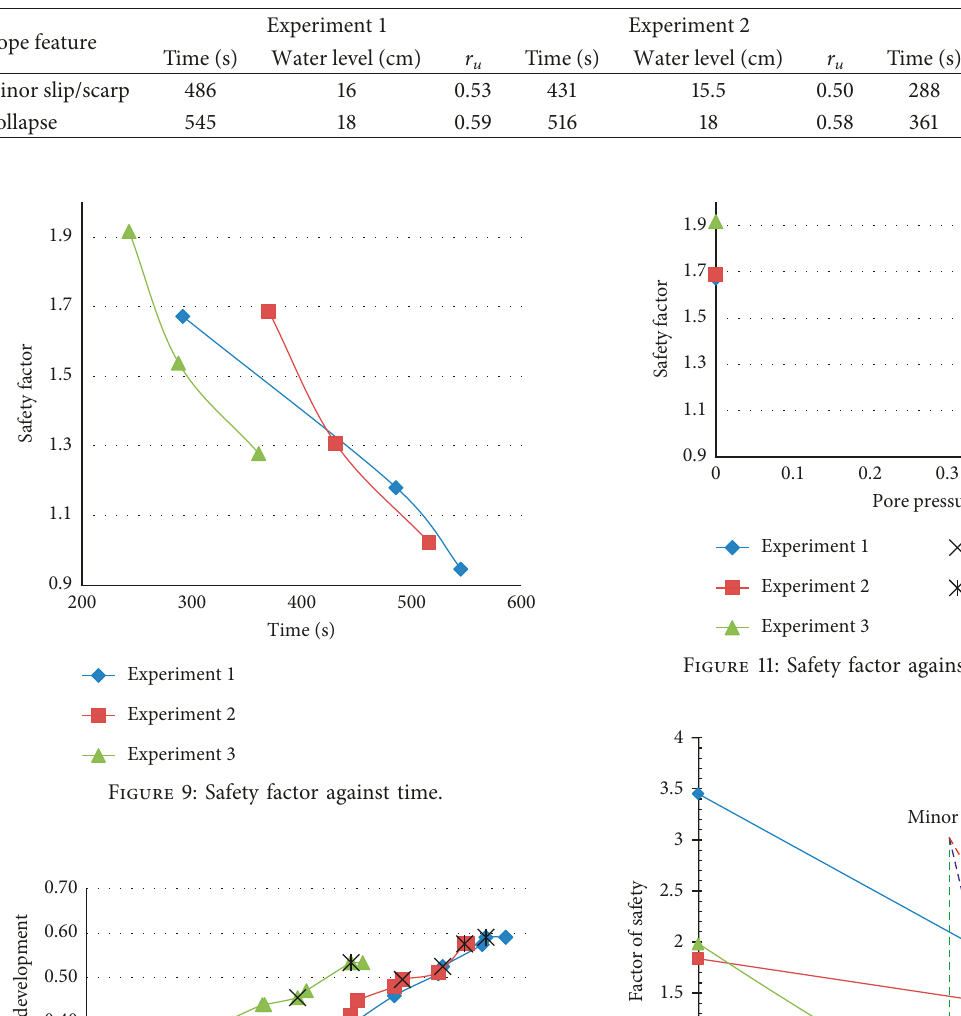
Table 2: Water level and pore pressure ratio onset of minor slip and collapse.